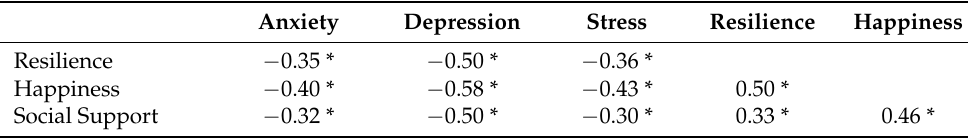
Table 3. Correlations between criterion and predictor variables.